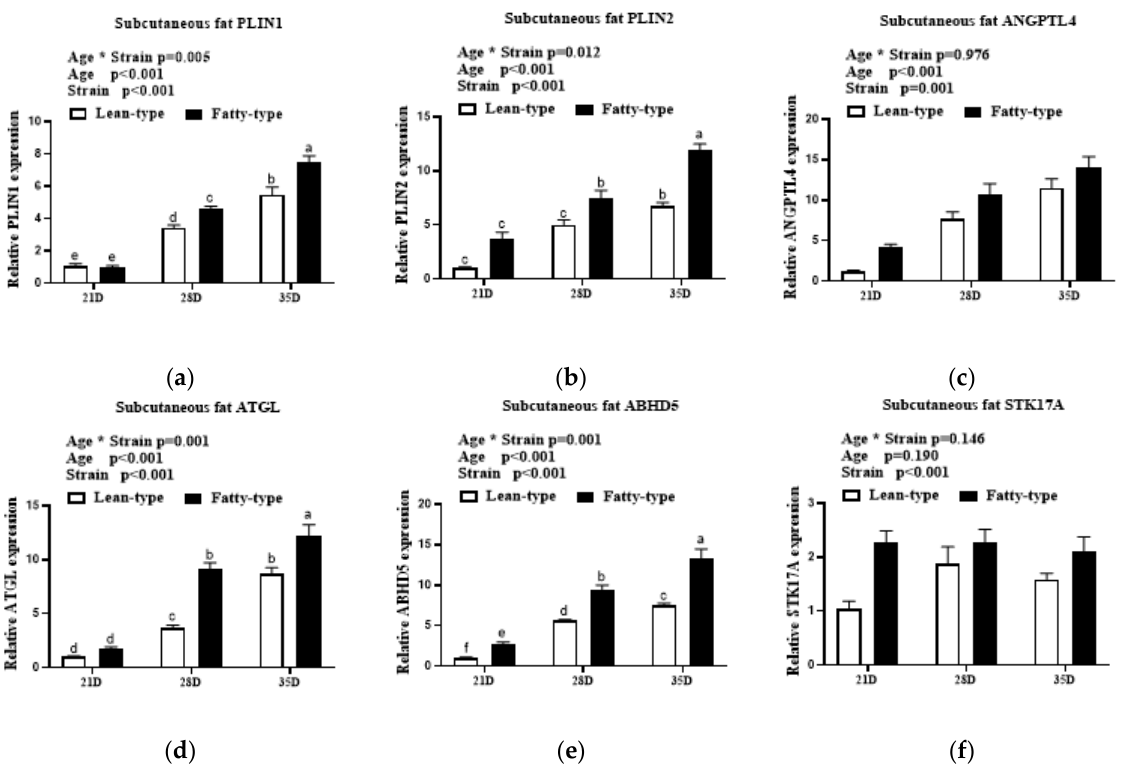
Figure 7. Comparison of expression levels of lipid droplet anabolism genes in subcutaneous fat ( a – f ) at 21 D, 28 D, and 35 D between two strains of meat ducks. Data are given as means and standard error of the mean ( n = 6). Bars with different letters are significantly different ( p < 0.05). * In the figure represents the interaction between the two factors. Abbreviations: PLIN1 , perilipin 1; PLIN2 , perilipin 2; ANGPTL4 , angiopoietin-like protein 4; ATGL , adipose triglyceride lipase; ABHD5 , abhydrolase domain containing 5; STK17A ; serine/threonine kinase